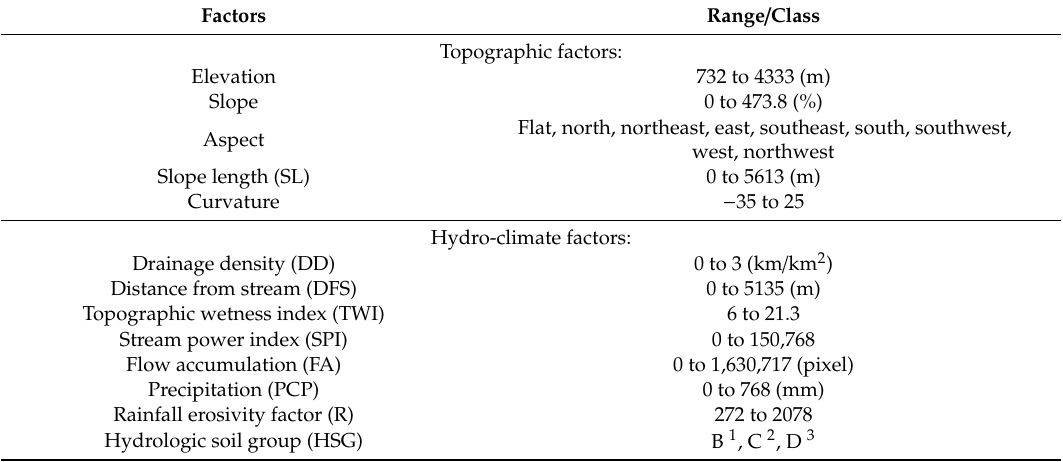
Table 1. Characteristics of the considered factors for susceptibility mapping of water erosion.